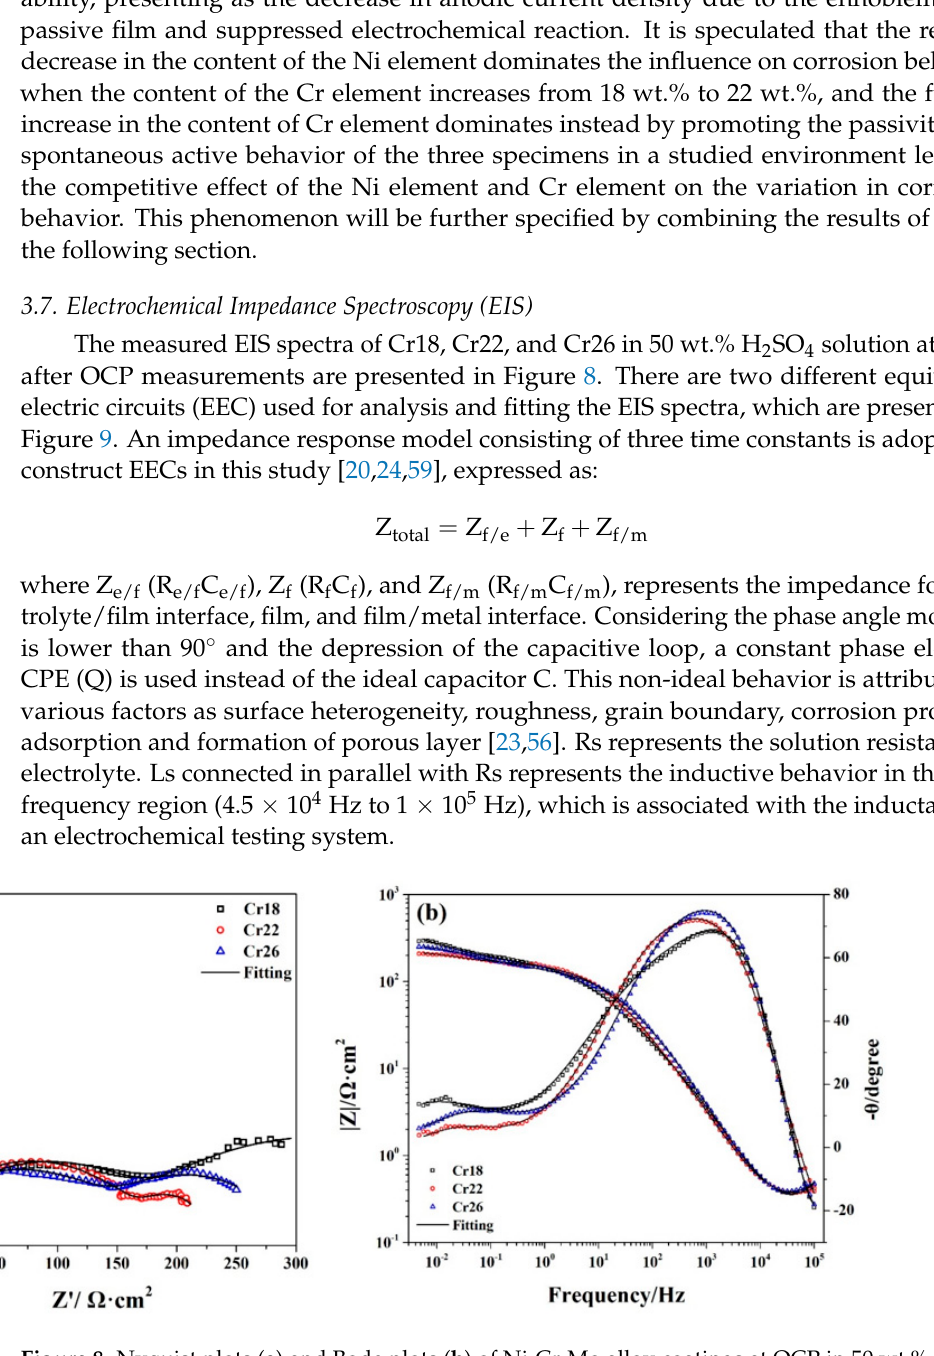
Figure 8. Nyquist plots ( a ) and Bode plots ( b ) of Ni-Cr-Mo alloy coatings at OCP in 50 wt.% H 2 SO 4 solution at 60 °C.